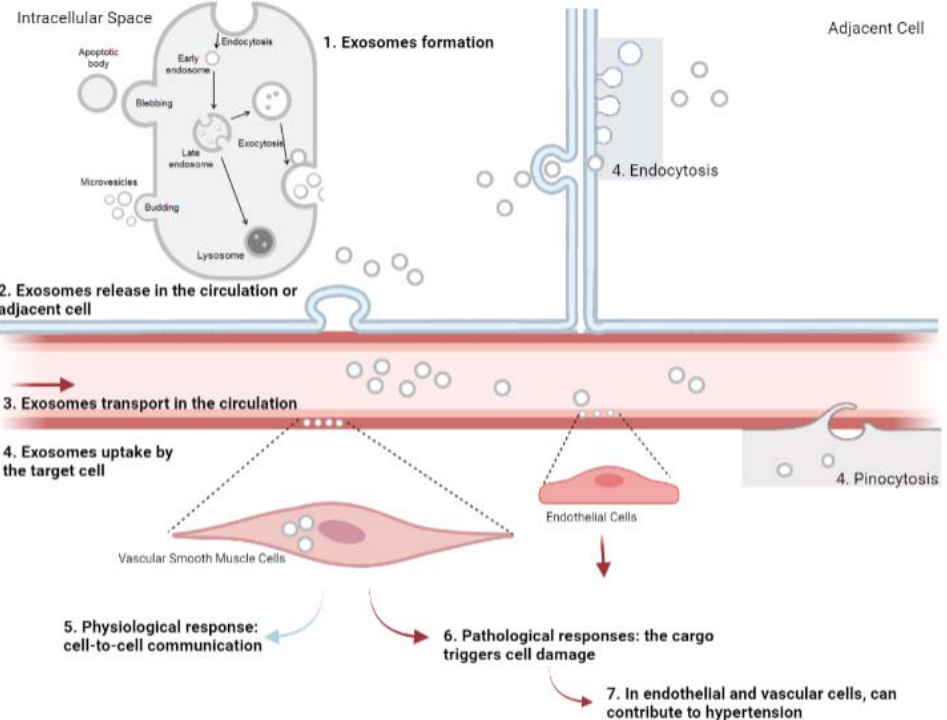
Figure 2. Exosomes mediate intercellular communication, contributing to hypertension. 1. Exosomes are formed by late endosomes in cells, budding into microvesicles; 2. exosomes are released by exocytosis into the circulation or in adjacent cells; 3. once exosomes are in the circulation, their cargo and affinity for the cell membrane will determine which cells are their target; 4. several types of cell, including immune cells, smooth muscle cells, and cancer cells, can uptake exosomes by different mechanisms, such as pinocytosis, phagocytosis, endocytosis, and internalization; 5. physiologically, the cargo of exosomes promotes cell-to-cell communication; 6. however, some contents of exosomes may trigger pathological responses, leading to diseases; 7. ultimately, in endothelial and vascular smooth muscle cells, the release of some miRNAs and other proteins from exosomes can cause endothelial/vascular dysfunction and contribute to the development of